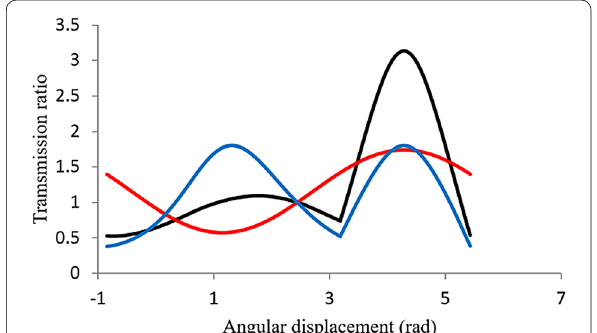
Figure 12 Comparison graphs of three transmission ratios (red line– the first transmission ratio; blue line–the second transmission ratio; black line–the total transmission ratio)